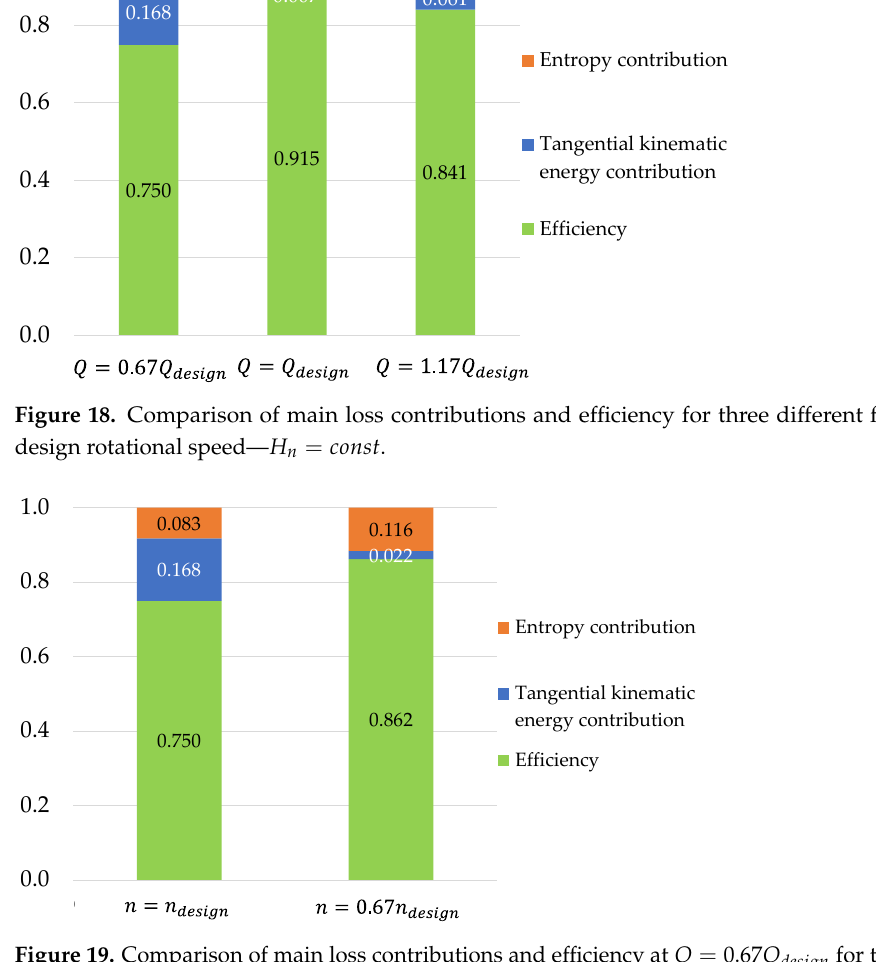
Figure 19. Comparison of main loss contributions and efficiency at Q = 0.67 Q design for two different rotational speeds— H n = const .